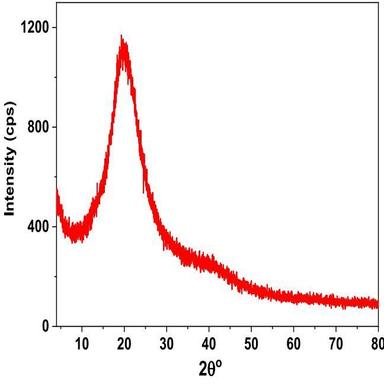
X-ray diffraction pattern of PVA thin film.